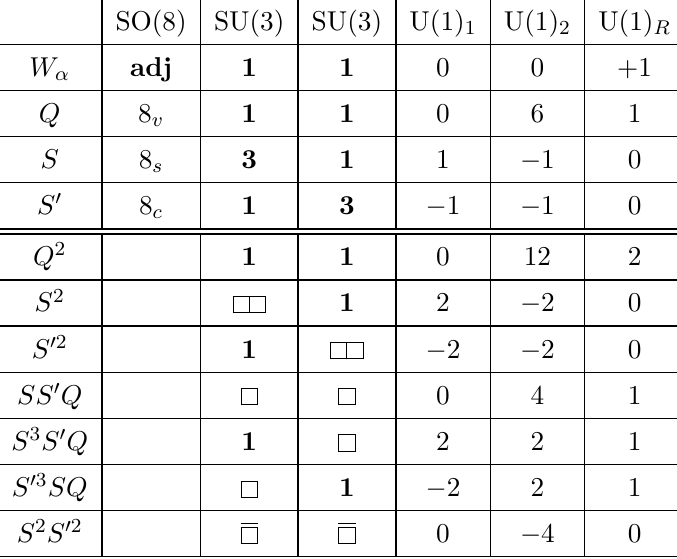
The P Z 2 anomalies are matched 2 F